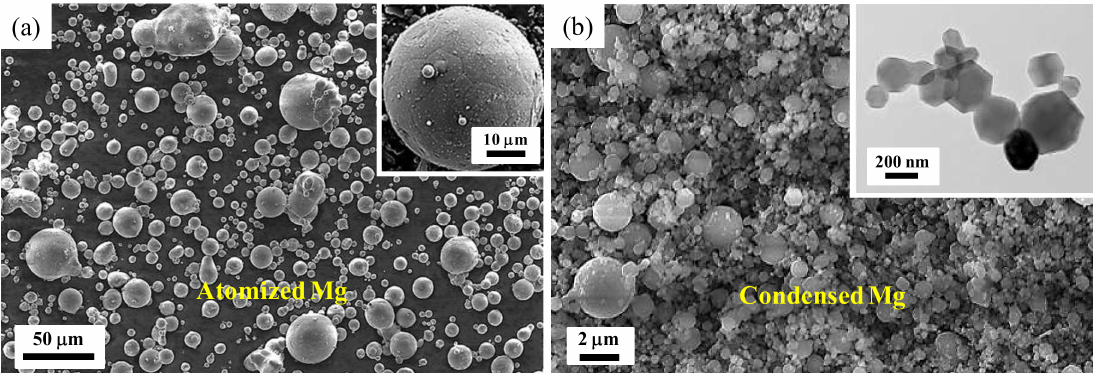
Figure 1. Morphological features of the initial powder precursors: ( a ) scanning electron microscopy (SEM) image of the atomized Mg particles accompanied with a magnified image of a particle showing grain structures (inset); ( b ) SEM image and a typical bright field tunneling electron microscopy (TEM) image (inset) of the condensed Mg